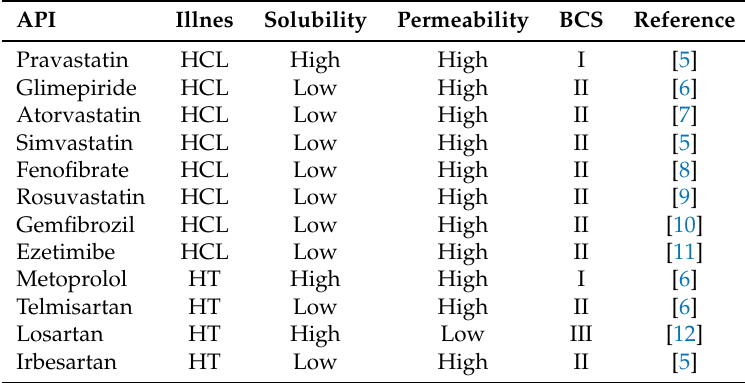
Table 1. Principal active pharmaceutical ingredients (APIs) used in the treatment of hypertension (HT) and hypercholesterolemia (HCL) and their respective classification in the biopharmaceutical classification system